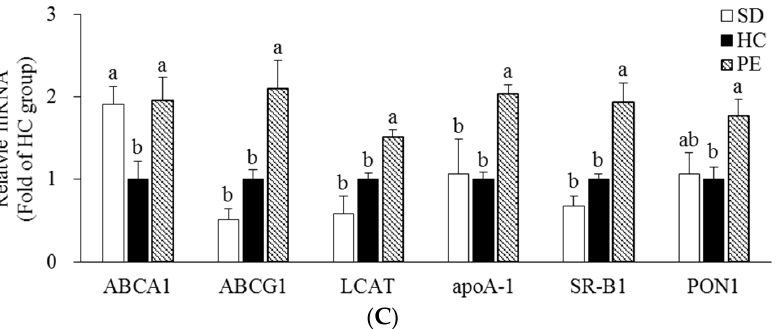
Figure 2. Effects of PE on mRNA levels of genes related to cholesterol metabolism in the liver. ( A ) The mRNA levels of LXR ‐α , ABCG5, and ABCG8. ( B ) The mRNA levels of CYP7A1 and FXR. ( C ) The mRNA levels of ABCA1, ABCG1, LCAT, apoA ‐ 1, SR ‐ B1, and PON1. Data are expressed as fold change compared with the HC group and expressed as mean ± SE ( n = 8). Bars with different letters (a, b, c) are statistically different at p < 0.05 by Tukey’s test. SD, standard diet; HC, high ‐ cholesterol diet; PE, HC + 0.8% extruded Portulaca oleracea L. extract. ABCA1, ATP ‐ binding cassette subfamily